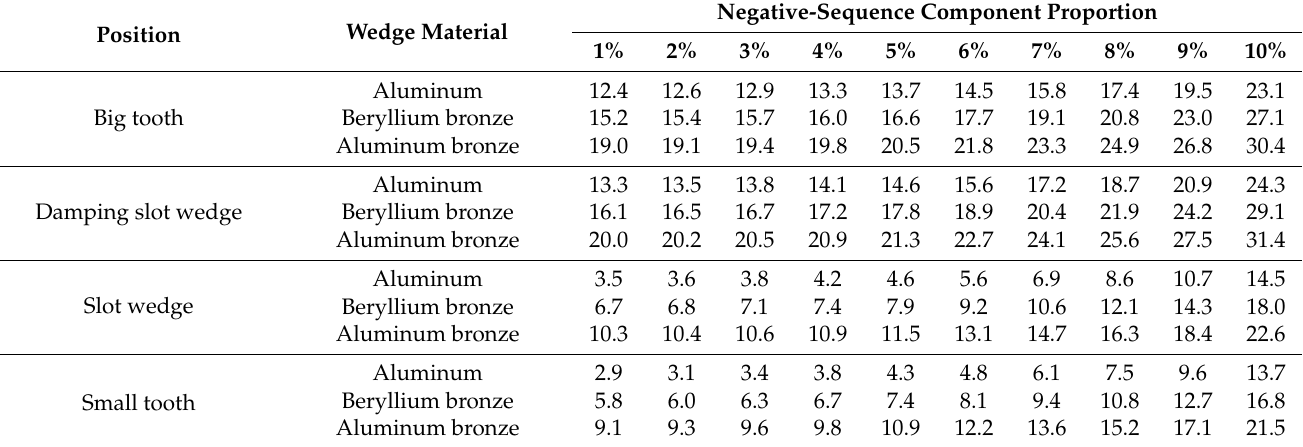
Table 4. The maximum temperature-rise prediction results, when negative-sequence component proportion changes from 1% to 10%, under the condition of using different wedge